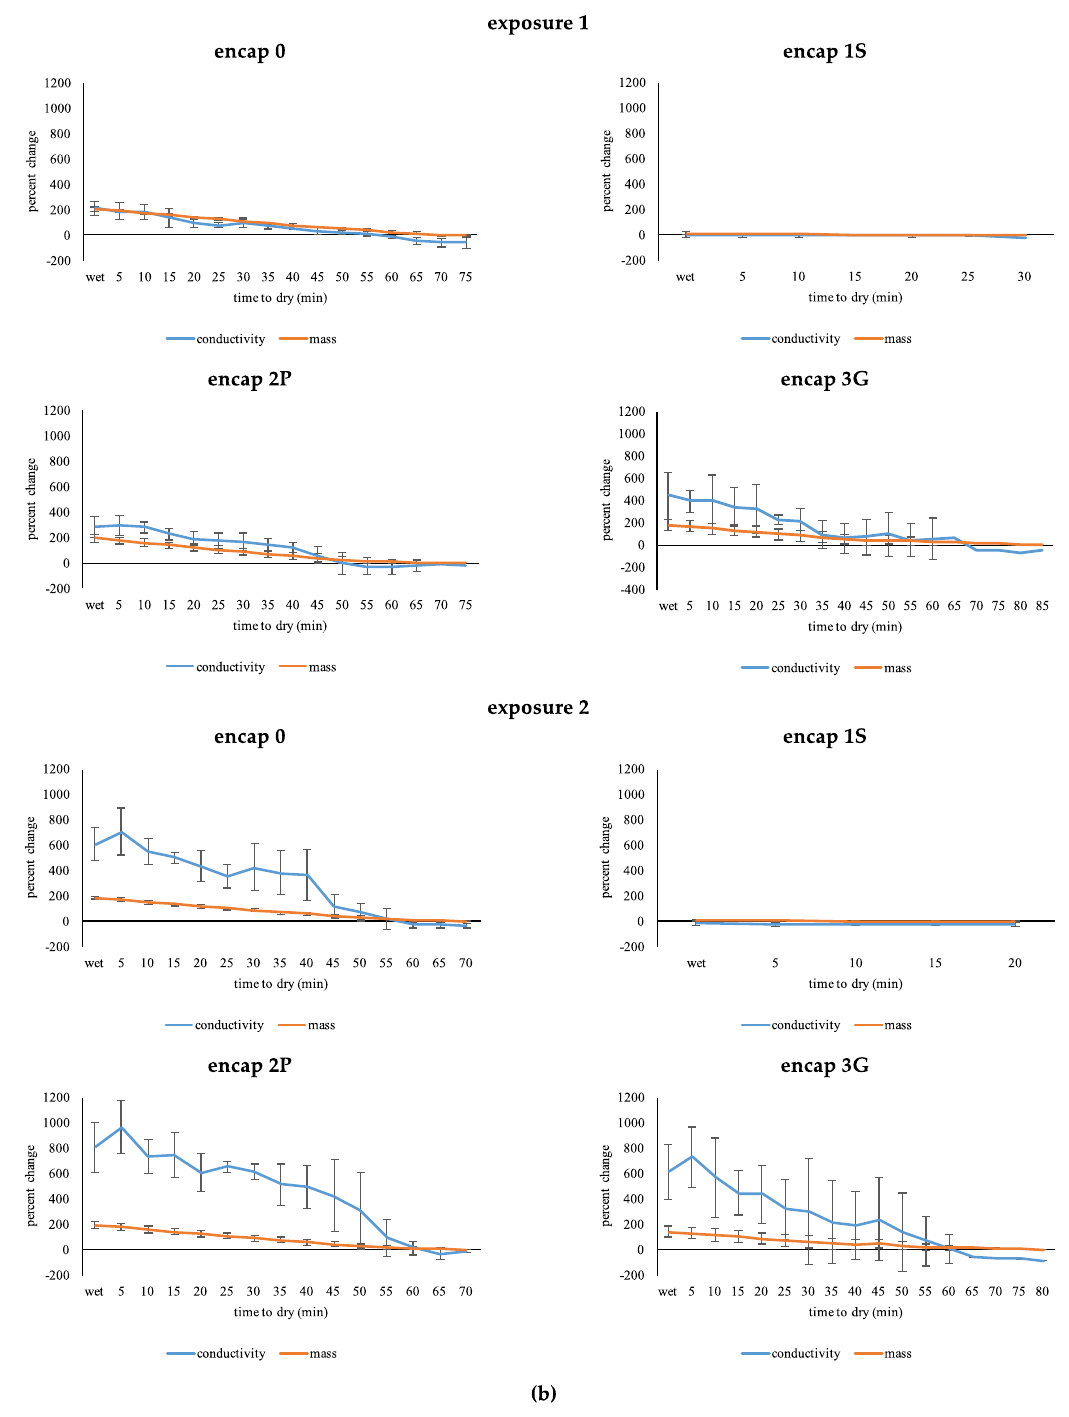
Figure 1. E ff ect of wetting on mass and electrical conductivity. ( a ) Wool. ( b ) Figure 1. Effect of wetting on mass and electrical conductivity. ( a ) Wool. ( b ) Cotton.